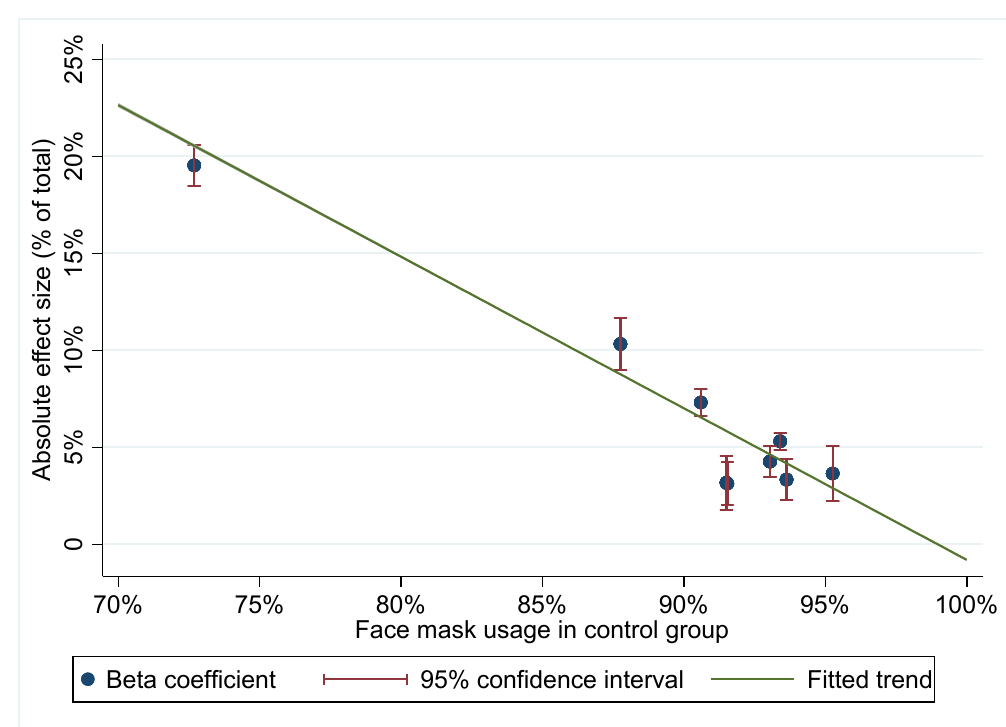
Figure 4. Effect size by level of face mask usage in control group. Int. J. Environ. Res. Public Health 2021 , 18 , x